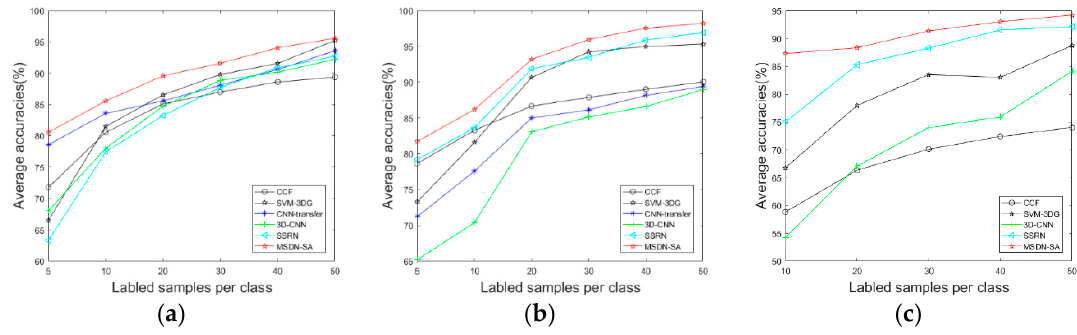
Figure 9. Effect of number of training samples on: ( a ) Indian Pines dataset. ( b ) University of Pavia dataset. ( c ) University of Houston dataset.